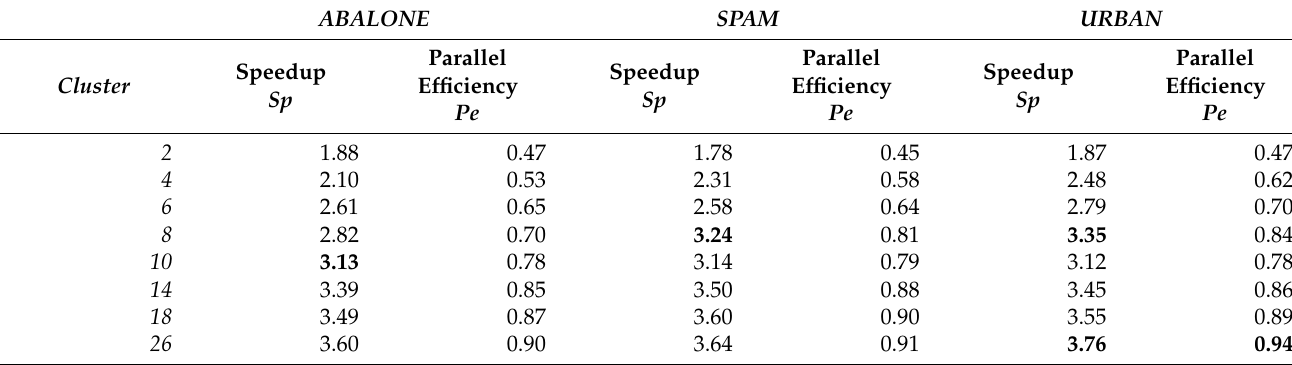
Table 3. Results of Experiment